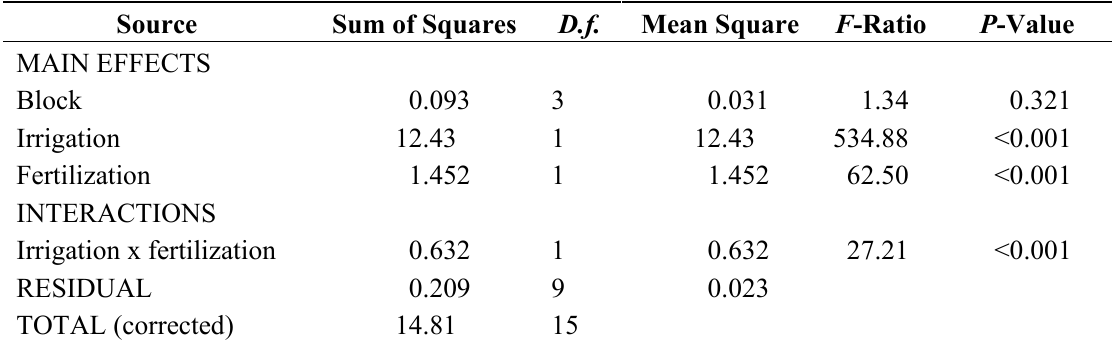
Table 4. ANOVA to identify the significant effects ( p < 0.05) in the stem biomass production (t ⋅ ha − 1 ) at stand level ( n = 16); all the F -ratios are based on the residual mean square error; D.f. is the number of degrees of